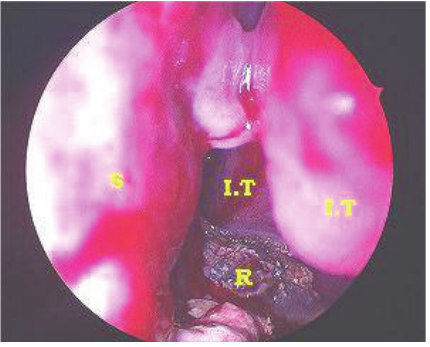
Figure 1: Rhinoscopy view of rhinolith (IT: inferior turbinate, S: septum, R: rhinolith).